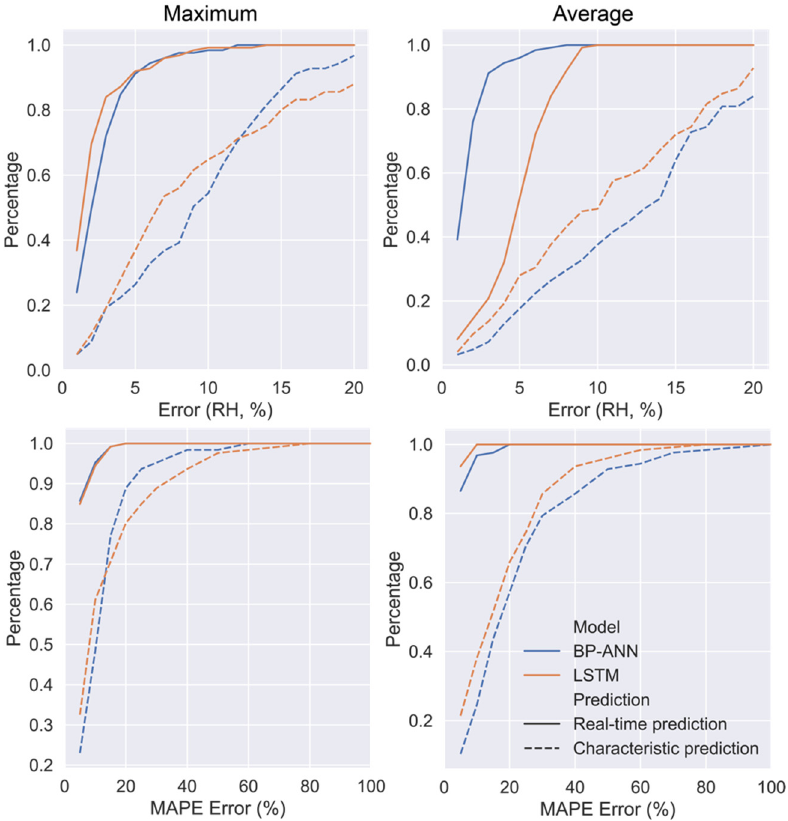
Figure 11. The x-accuracy prediction results of daily RH using BP-ANN and LSTM techniques in Model 1 and 2.